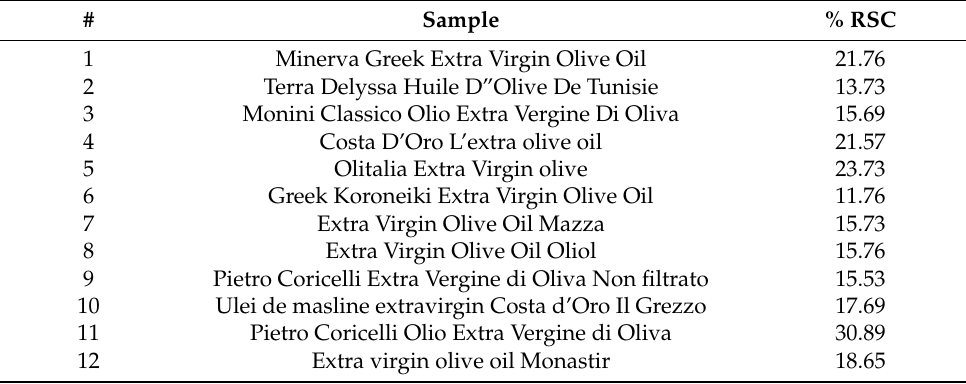
Table 7. Determination of % RSC of HT in EVOO